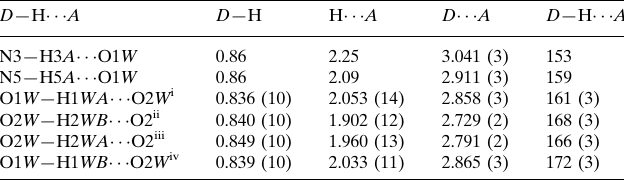
Hydrogen-bond geometry (A˚ , (cid:2)